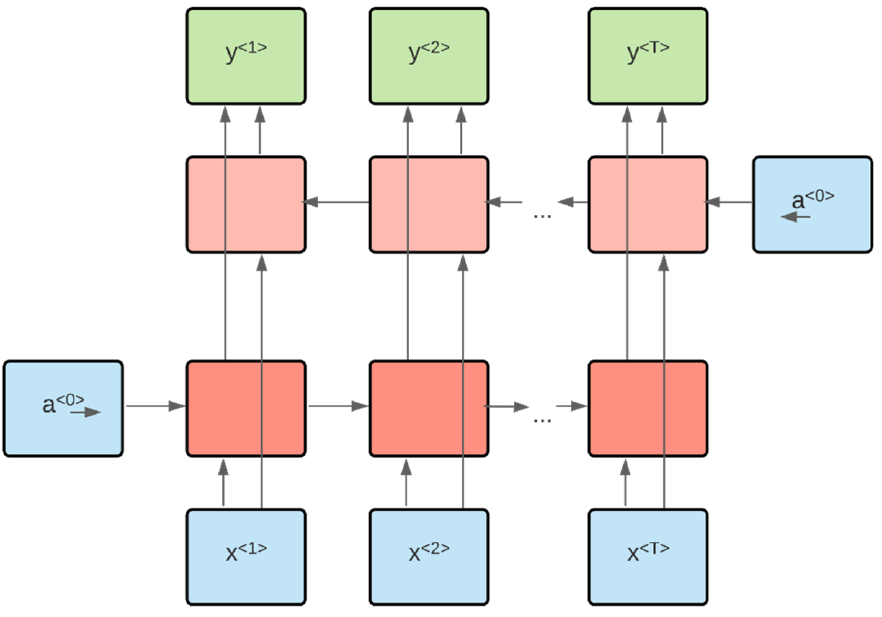
Figure 2. Bidirectional LSTM